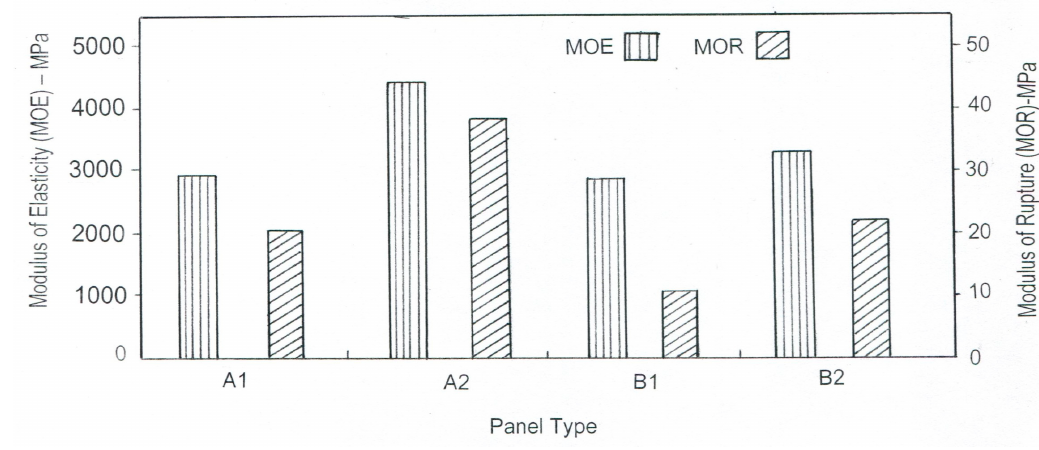
Figure 3. Bending characteristics of the samples.